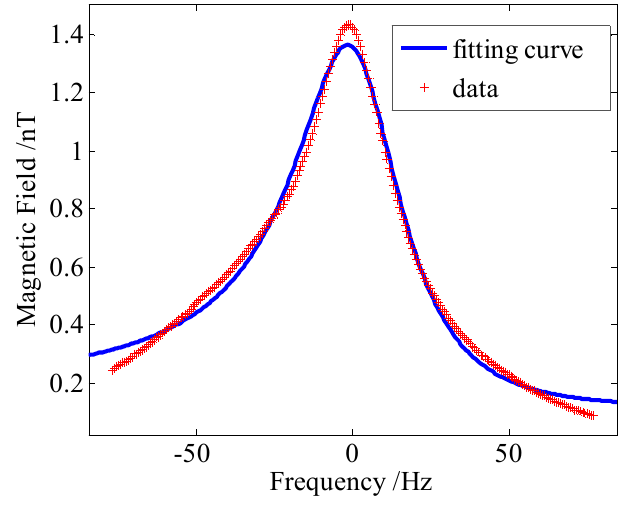
Figure 11. Test result of the light shift L z . The pumping power was 50 mW.